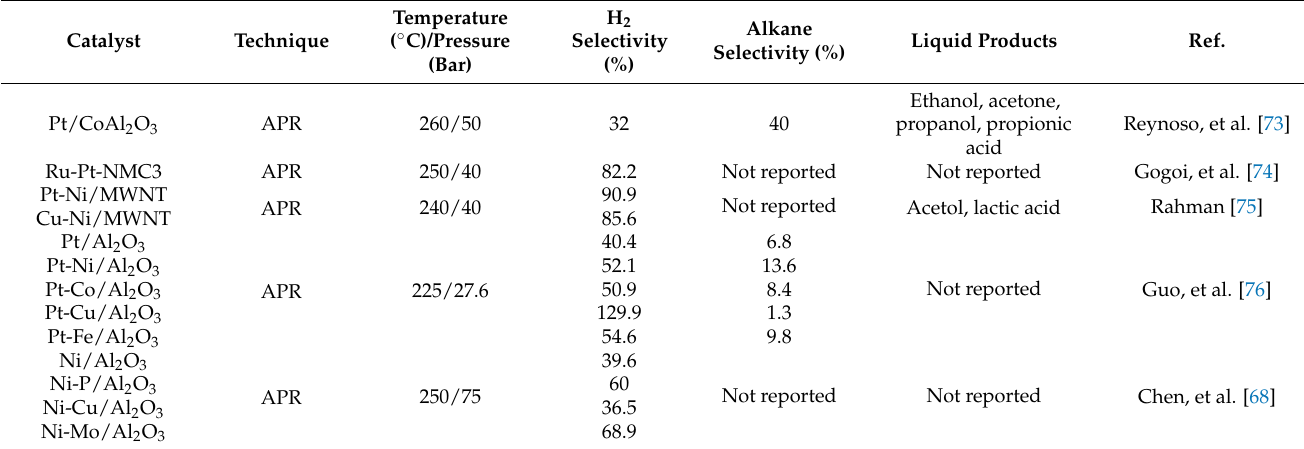
Table 1. Aqueous phase reforming of glycerol with other thermochemical